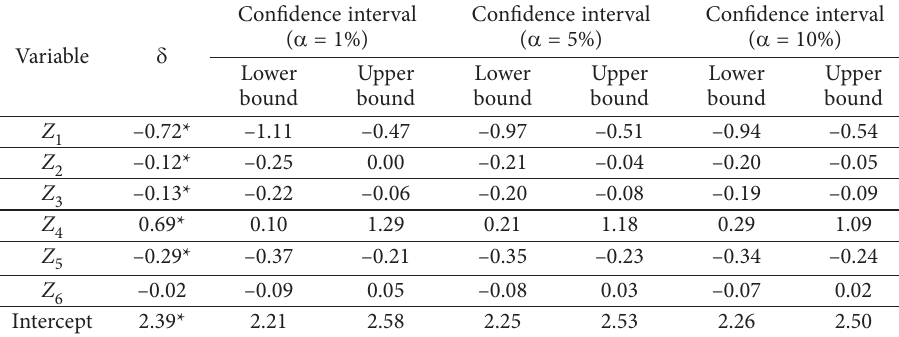
Table 5. Results of the bootstrap truncated regression using pooled data